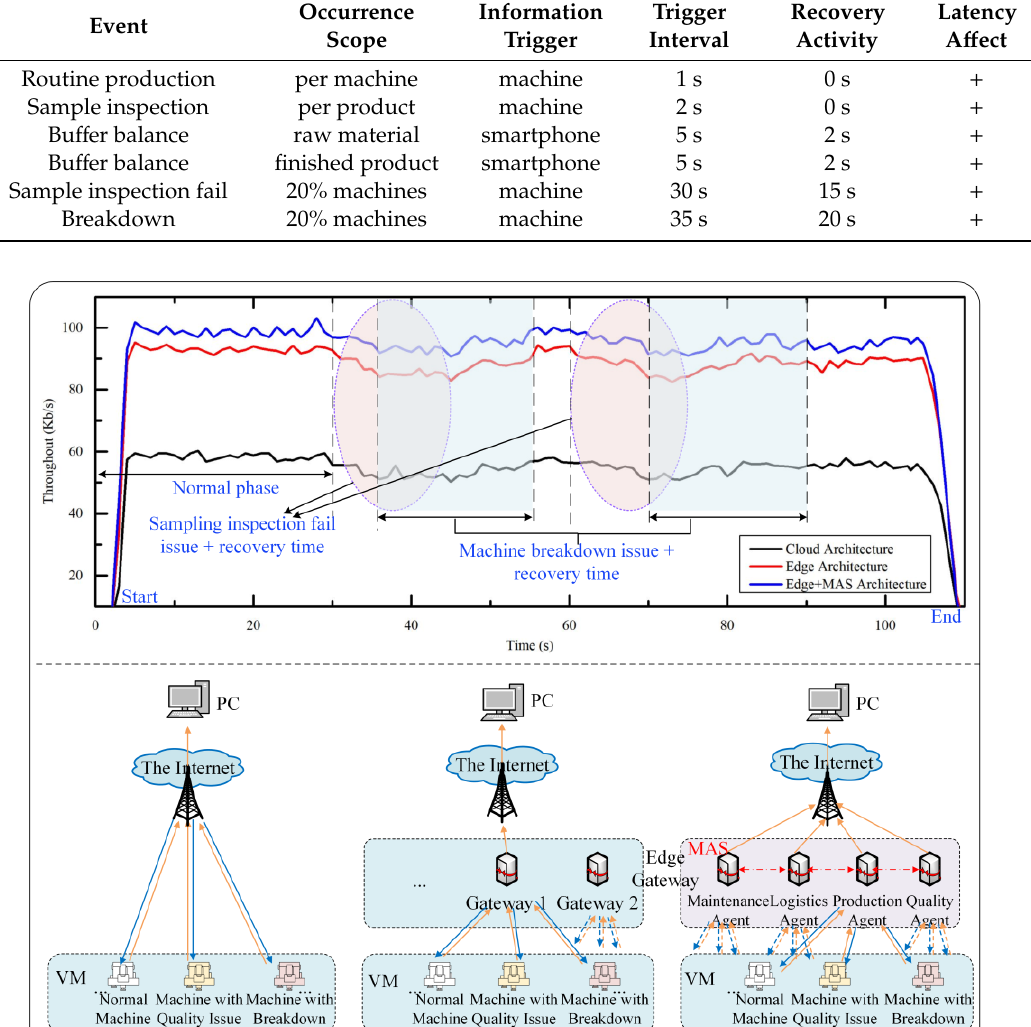
Table 1. Basic events of the simulative manufacturing environment.